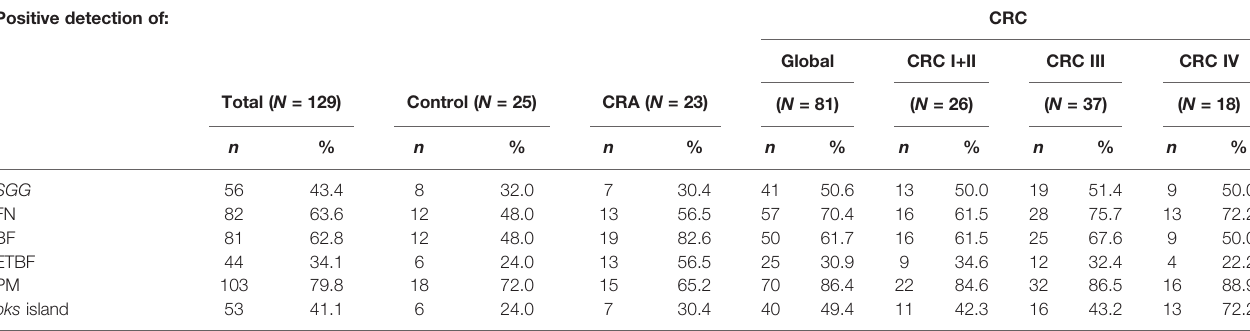
TABLE 2 | Detection of Streptococcus gallolyticus subsp. gallolyticus (SGG), Fusobacterium nucleatum (FN), Bacteroides fragilis , enterotoxigenic B. fragilis (ETBF), Parvimonas micra (PM), and pks island in the stools from CRC, CRA, and control patients using the PCR assay. Positive detection